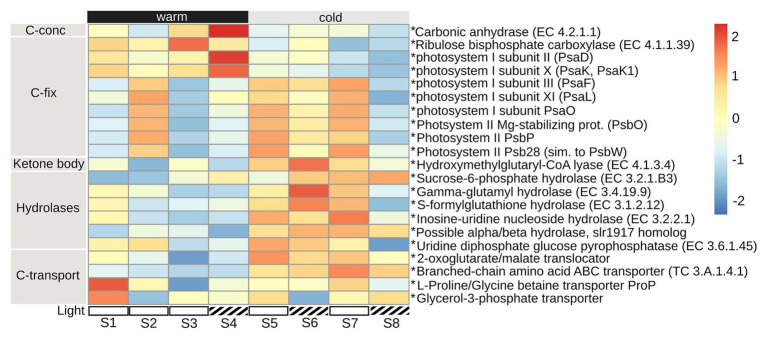
Eukaryote gene expression (metatranscriptome) of mechanisms associated with carbon acquisition. Included are key enzymes representative of: carbon concentration (C-conc) and carbon fixation (C-fix), ketone body formation, hydrolases, and carbon transport. Heatmap shows the mean of triplicates per sampling date (S1–S8), of counts normalized to TPM and then square root transformed. Heatmap was made using R package pheatmap, with setting scale by “row.” Warm: 19.5 ± 0.89°C, cold: 12.4 ± 1.76°C (mean temperature per 24 h in PBR); Light: light reduction, open bar → natural light, striped bar → light reduced by 40–60% by shading. * indicate padj < 0.01 for log2 fold change of differential expression, contrasted for warm vs. cold time period.